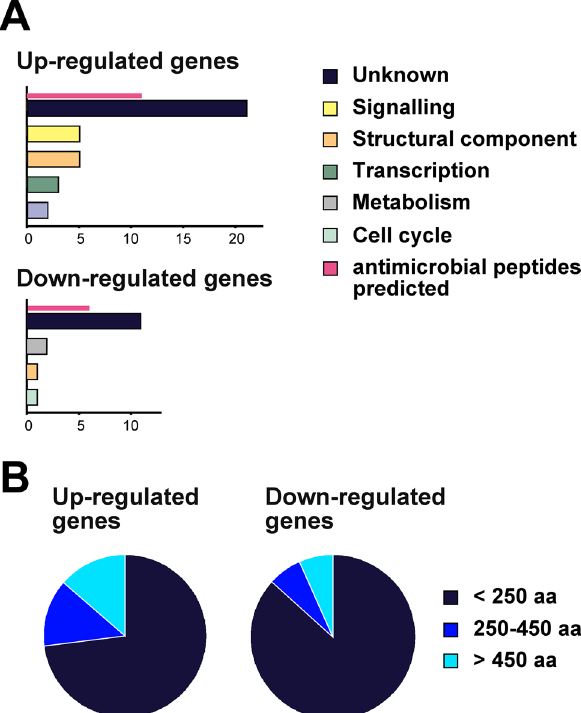
Figure 2. Classification of thiamethoxam induced differentially expressed genes according to function and size. ( A ) Numbers of genes are plotted according to functions for thiamethoxam induced differentially expressed genes with annotated functions for up- (top) and down-regulated (bottom) genes. ( B ) Pie charts indicating the fraction of thiamethoxam induced differentially expressed genes according the ORF length for up- (left) and down- (right) regulated